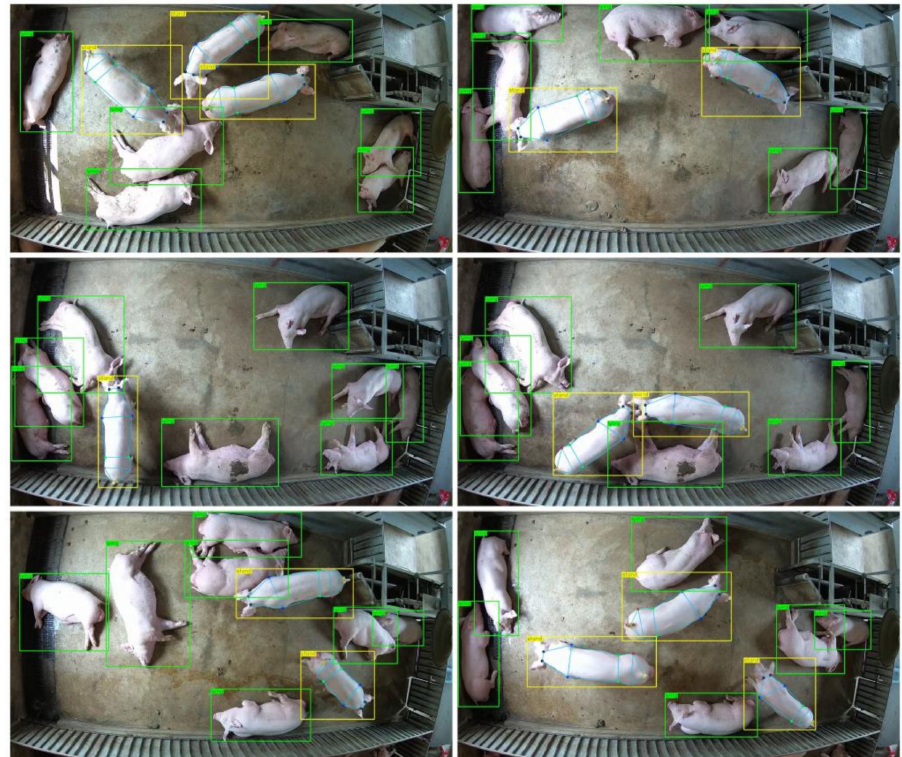
Figure 8. Example of multi-pig joint point detection. The green bounding box represents lying, and the yellow bounding box shows standing. Joint point detection is only performed on standing